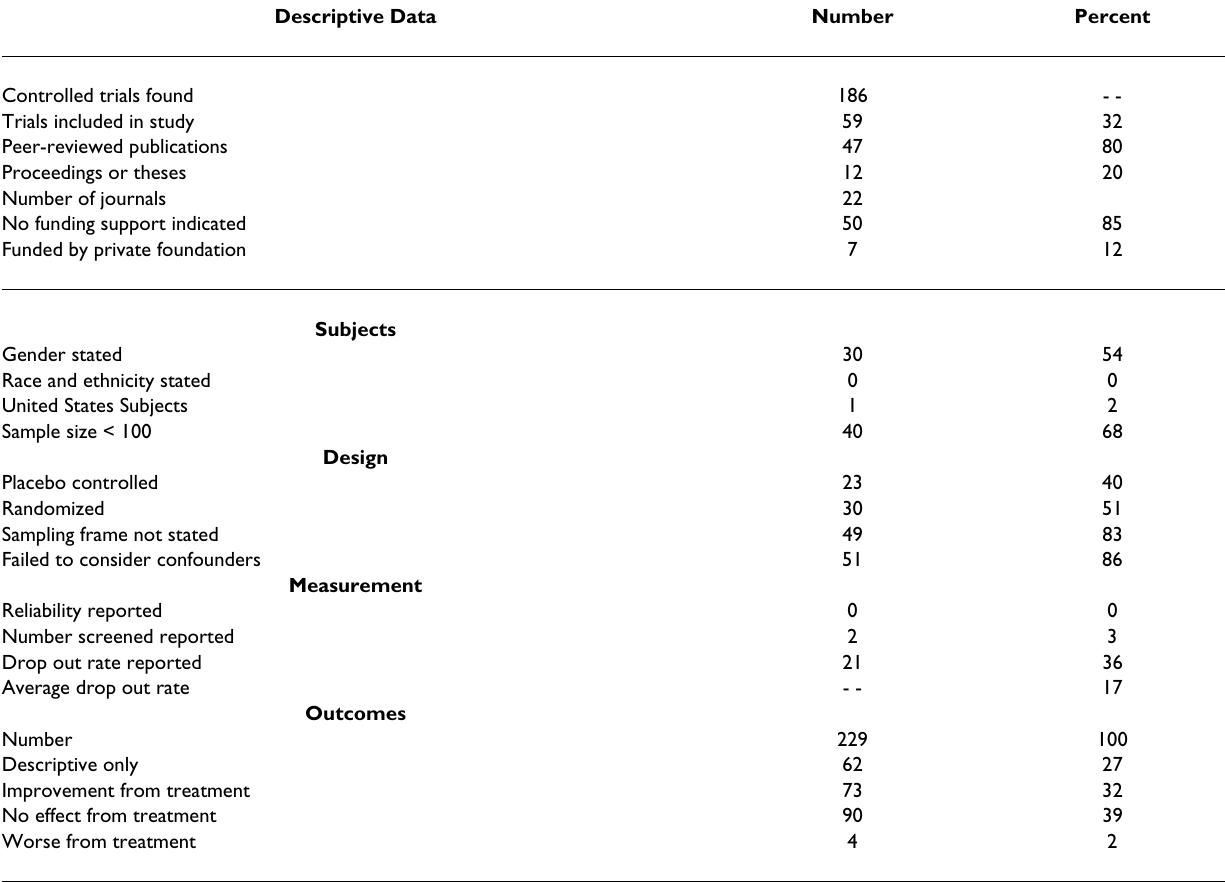
Table 2: Characteristics of the Clinical Trials in Homeopathy by Systematic Review Descriptive